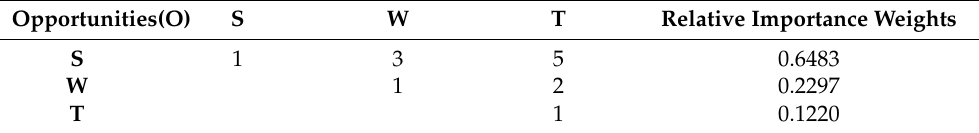
Table A6. The interdependence matrix of the SWOT factors with respect to “Opportunities”.